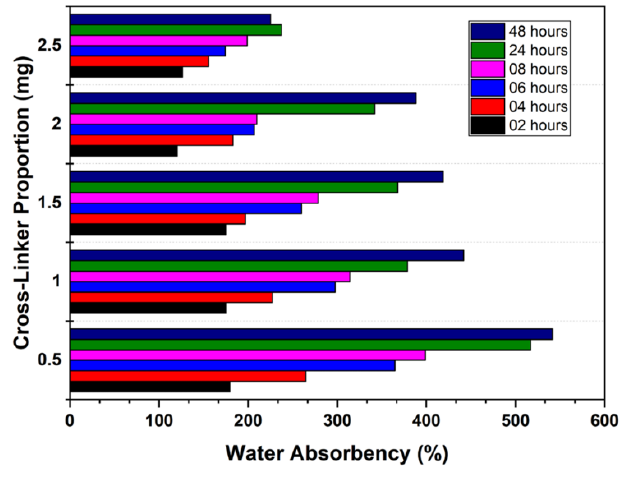
Fig. 6. Influence of cross-linker concentration on SAPCs water absorption at different time intervals